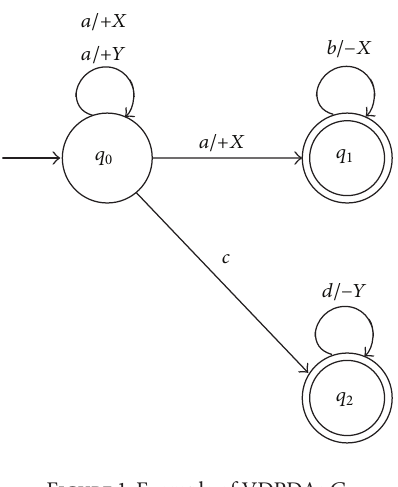
Figure 1: Example of VDPDAs 𝐺